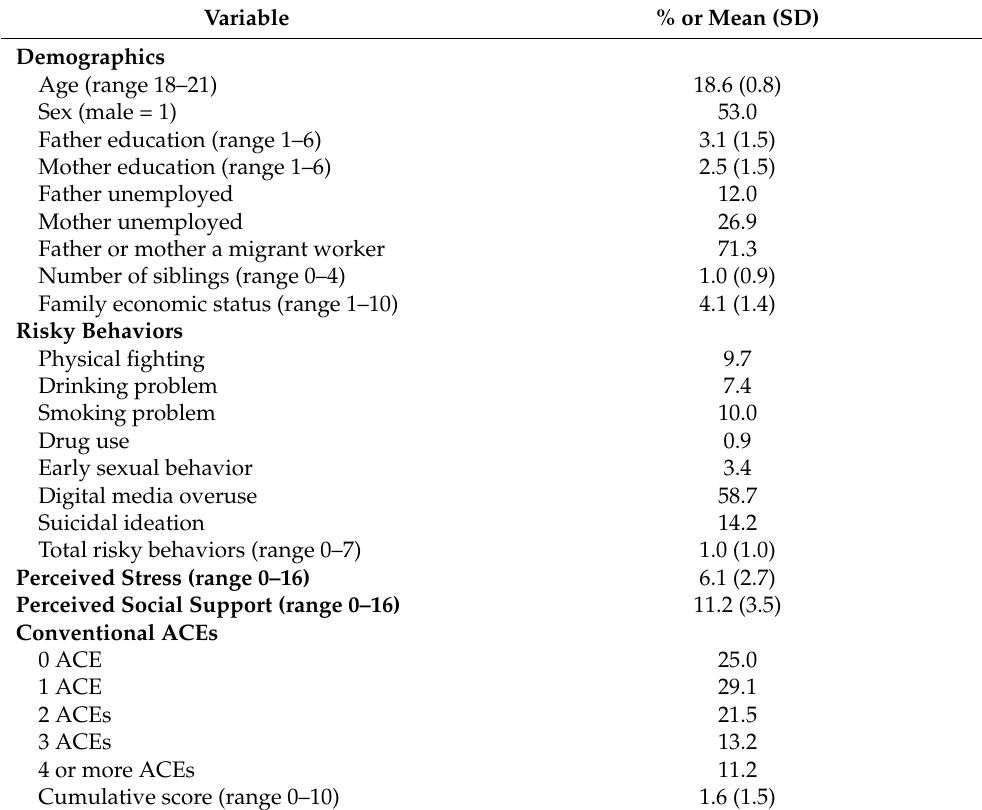
Table 1. Description of Study Measures (N =